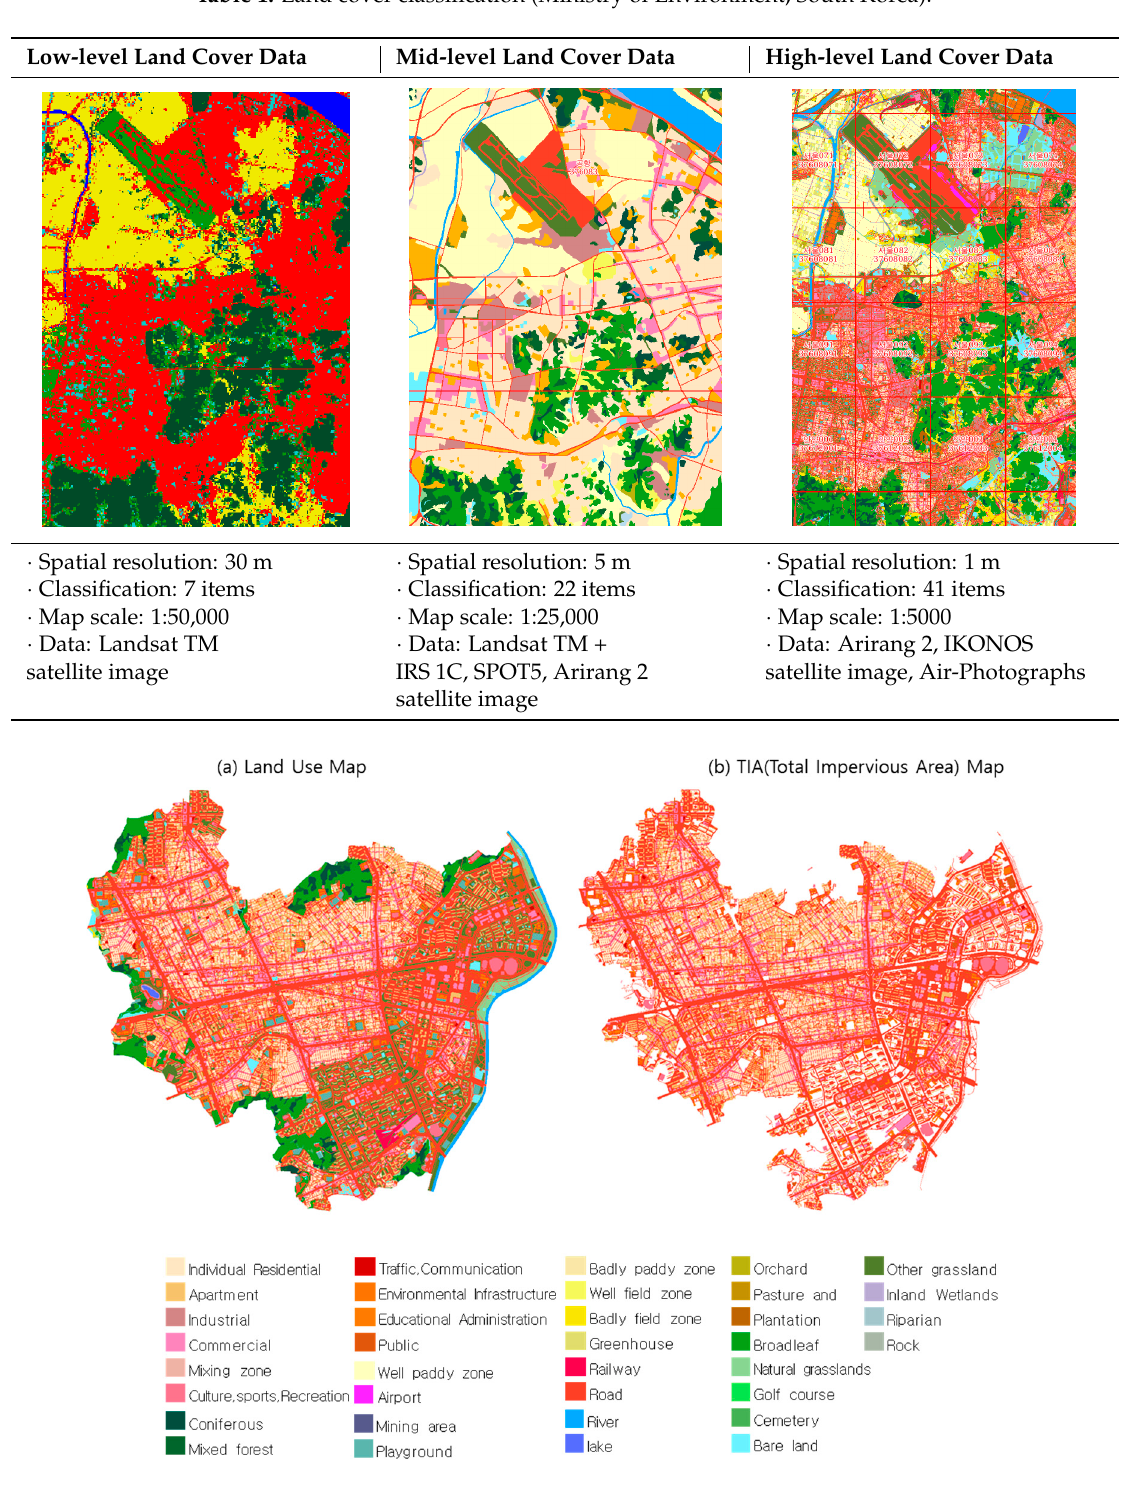
Figure 2. Land use map and total impervious area map identified from the detailed land use cover data of the Shinweol Basin.